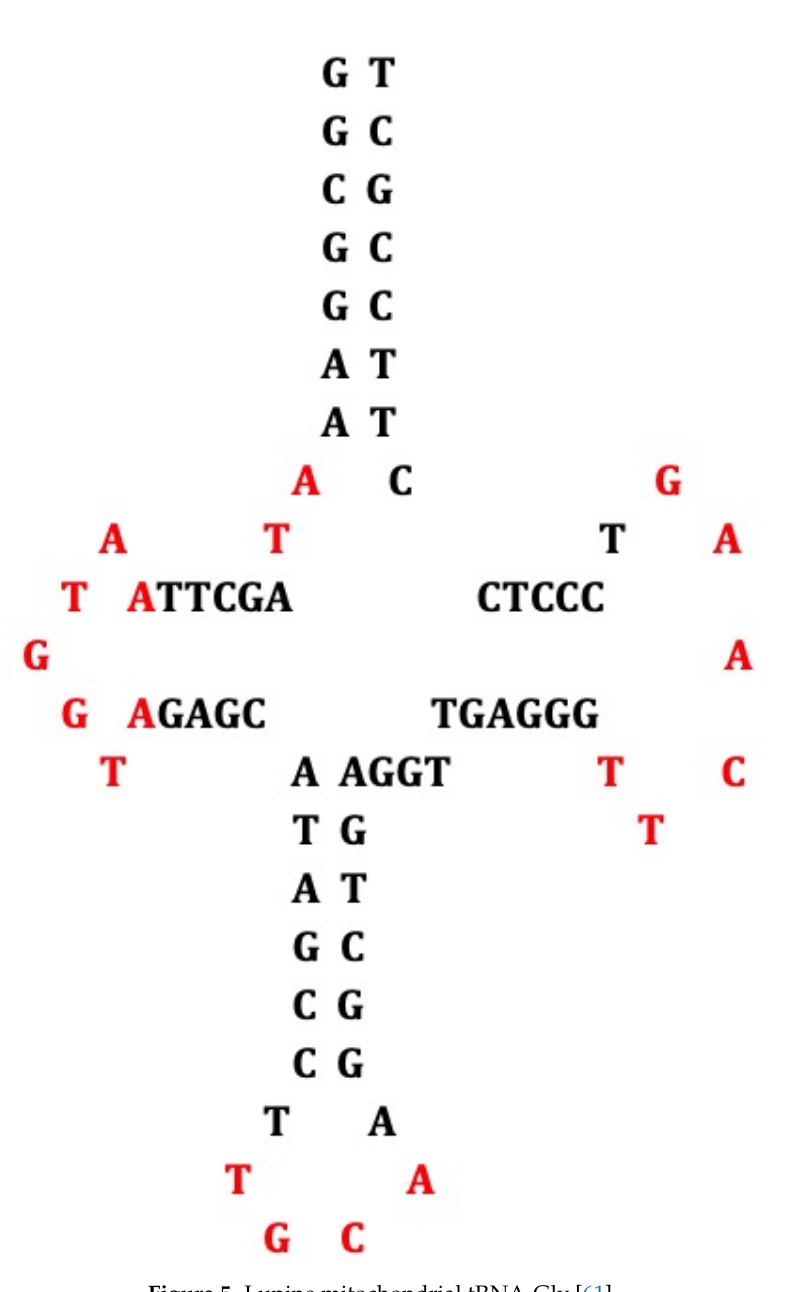
Figure 5. Lupine mitochondrial tRNA-Gly